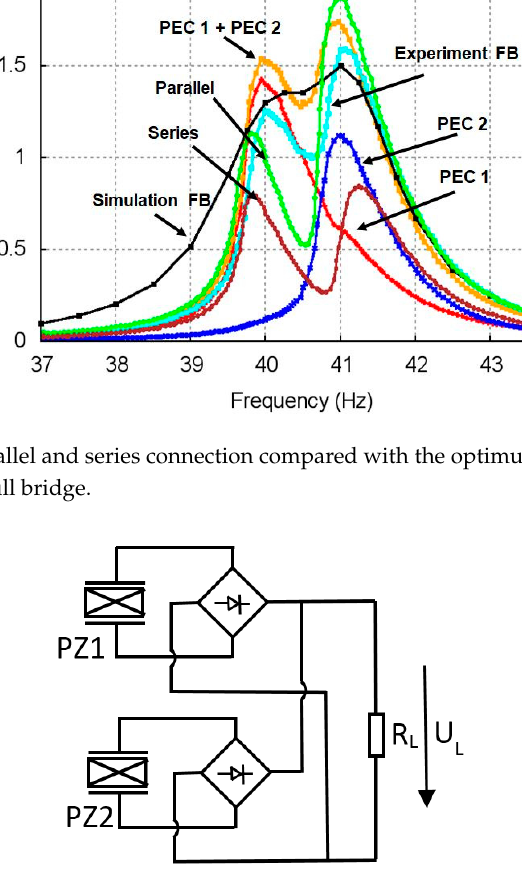
Figure 11. Two piezoelectric cantilevers (denoted as PZ1, PZ2) with the individual full wave bridge rectifiers connected parallel to the resistance R L.